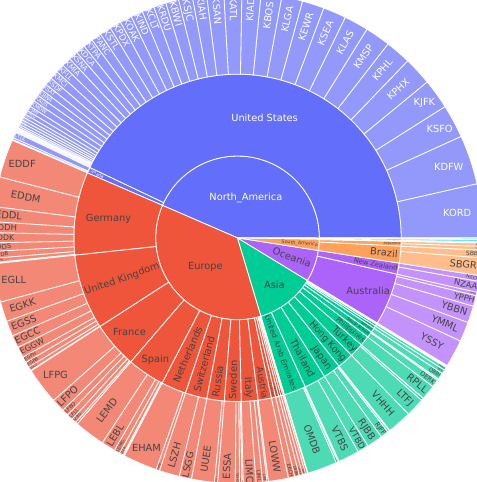
Figure 1. Proportion of the observed landings per region, country, and